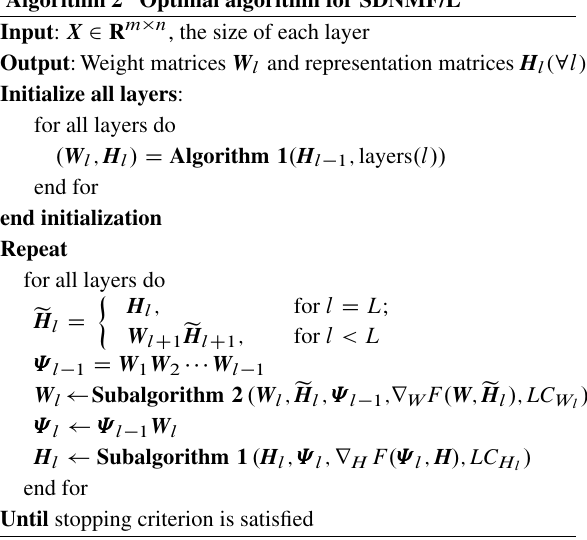
Algorithm 2 Optimal algorithm for